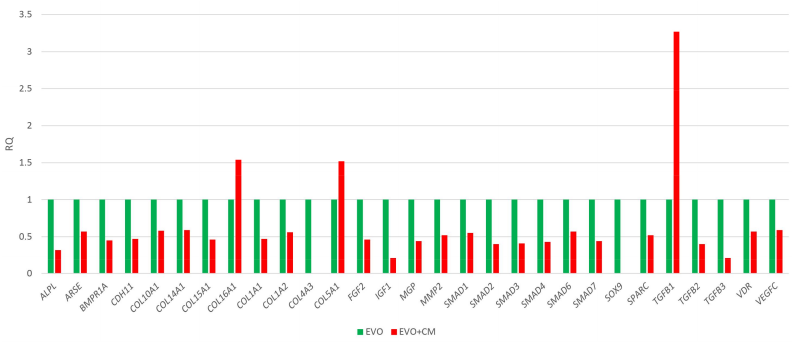
Figure 2. Relative gene expression folds by qRT-PCR. The bar-charts shows the significant relative gene expression folds in EVO + CM compared to EVO. In green the expression of the significant transcripts for the EVO, in red the expression of the significant transcripts for the condition analyzed. Data Assist software (3.01, Thermofisher, Milan, Italy) was employed to run the analysis using glyceraldehyde-3-phosphate dehydrogenase ( GAPDH ), glucuronidase β ( GUSB ), 18S ribosomal RNAs ( 18S ) and hypoxanthine phosphoribosyltransferase ( HPRT ) 1 as selected endogenous controls. The transcripts show a p -value < 0.05; p values were adjusted using Benjamini-Hochberg false discovery rate (FDR)